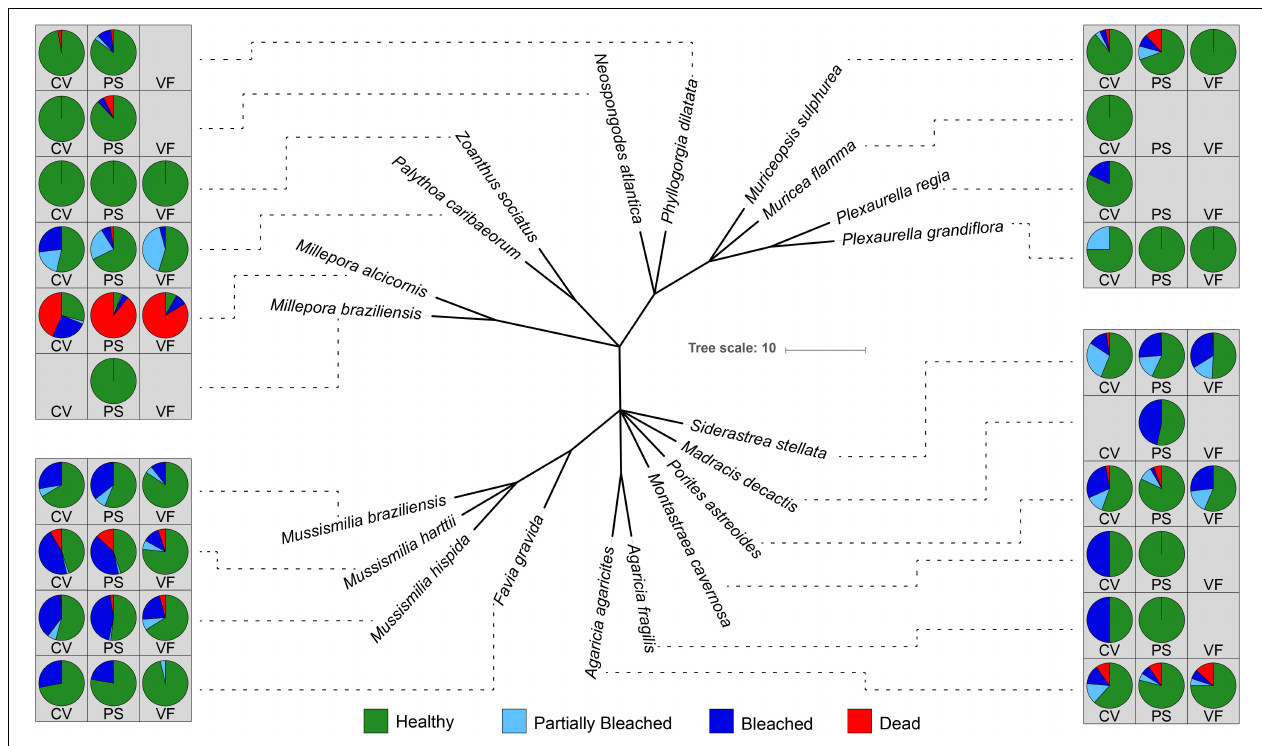
FIGURE 3 | Phylogeny of coral species found in sampling sites. Pie charts show the percent of healthy, partially bleached, bleached, or dead species in each species from each of the three reef collection sites (CV, Coroa Vermelha; PS, Pedra do Silva; VF, Virada de Fora). Millepora alcicornis showed the highest mortality in each of the three